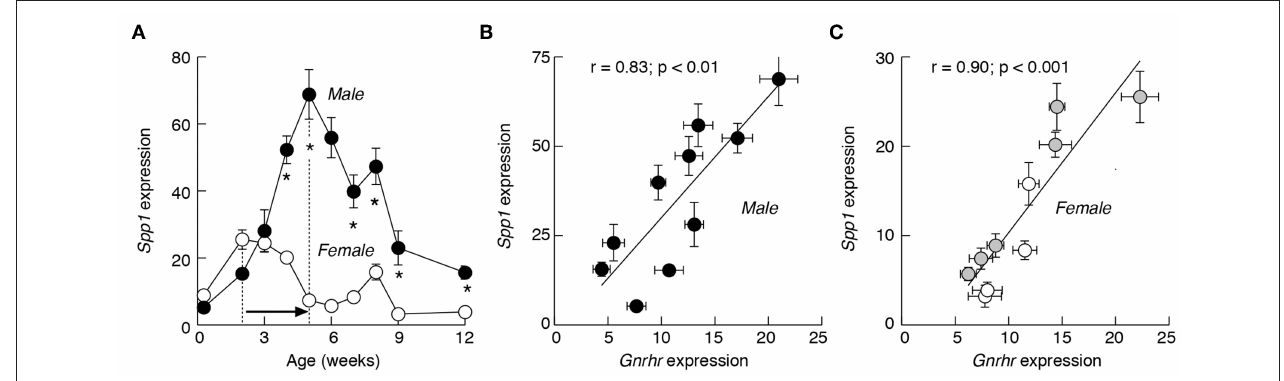
FIGURE 1 | The expression pattern of Spp1 mRNA in anterior pituitary of developing rats is comparable to Gnrhr expression. (A) The sex-specific developmental profiles of Spp1 expression. White circles: females; black circles: males. In postpubertal females, the mean values are derived from regularly cycling animals in proestrus, estrus, and diestrus 1 and 2 stages of the cycle. (B,C) The expression of Spp1 correlates with expression of Gnrhr , a gonadotroph marker gene, in male (B) and female (C) pituitaries. Data points shown are mean ± SEM values from 6 to 37 animals per group, relative to Gapdh (set as 100%). Correlation and linear regression analyses and statistical evaluation are described in Material and Methods; r , coefficient of correlation. The mean ± SEM values for Gnrhr are derived from ( 38). Asterisks indicate significant differences between pairs (A) ; the p values for r coefficient are shown on top of panels (B,C) . Gray circles, prepubertal females; white circle, postpubertal females (C) .